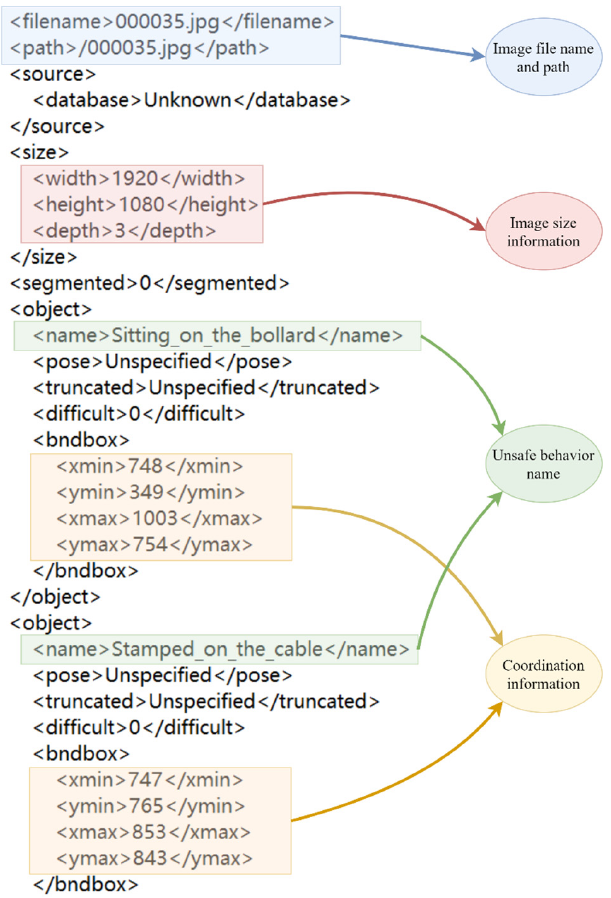
Figure 8. Example of an XML